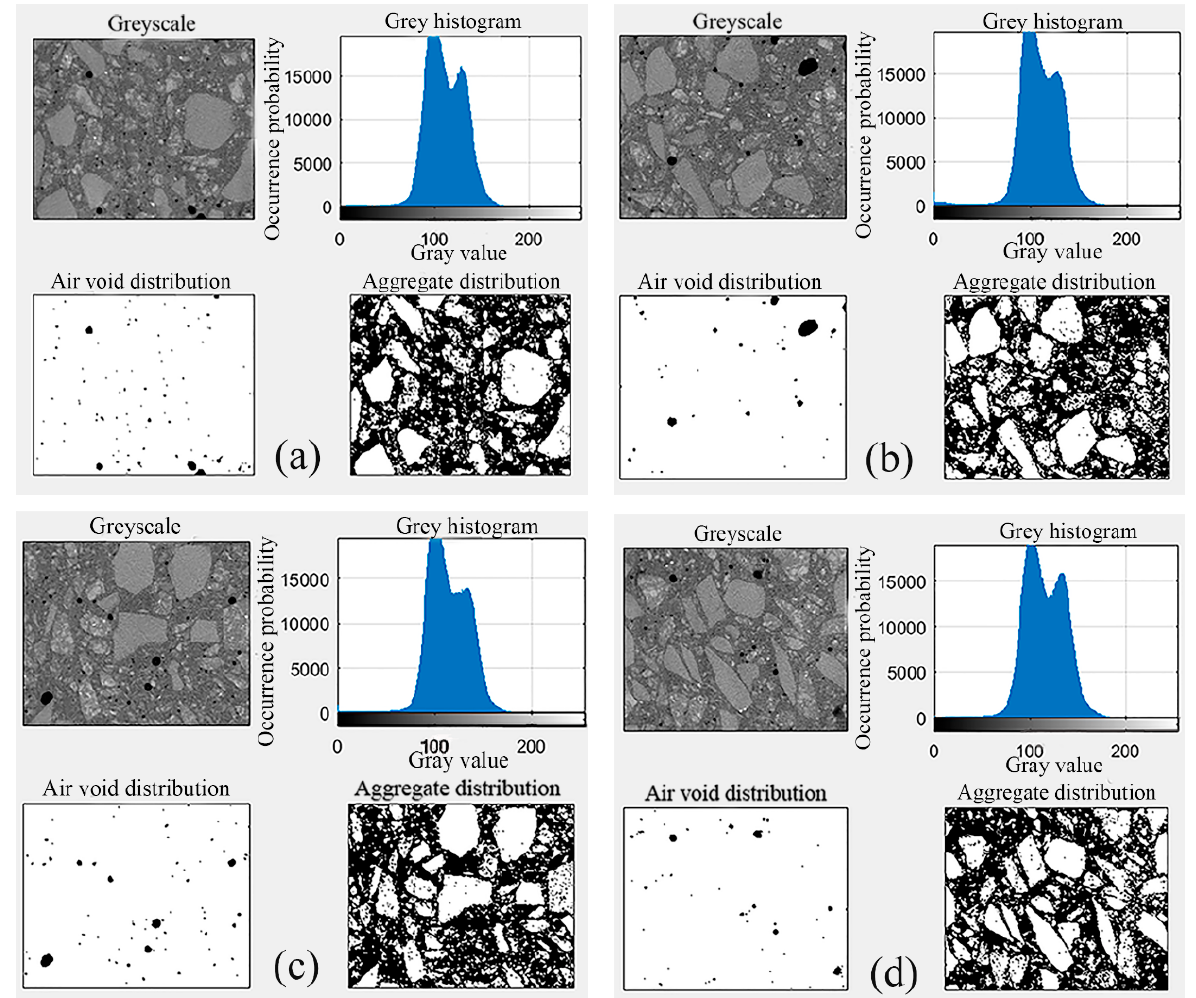
Figure 8. Images after greyscale treatment at the position of ( a ) one third of the TLA mix specimen length, ( b ) two thirds of the TLA mix specimen length, ( c ) one third of the QRA mix specimen length and ( d ) two thirds of the QRA mix specimen length.